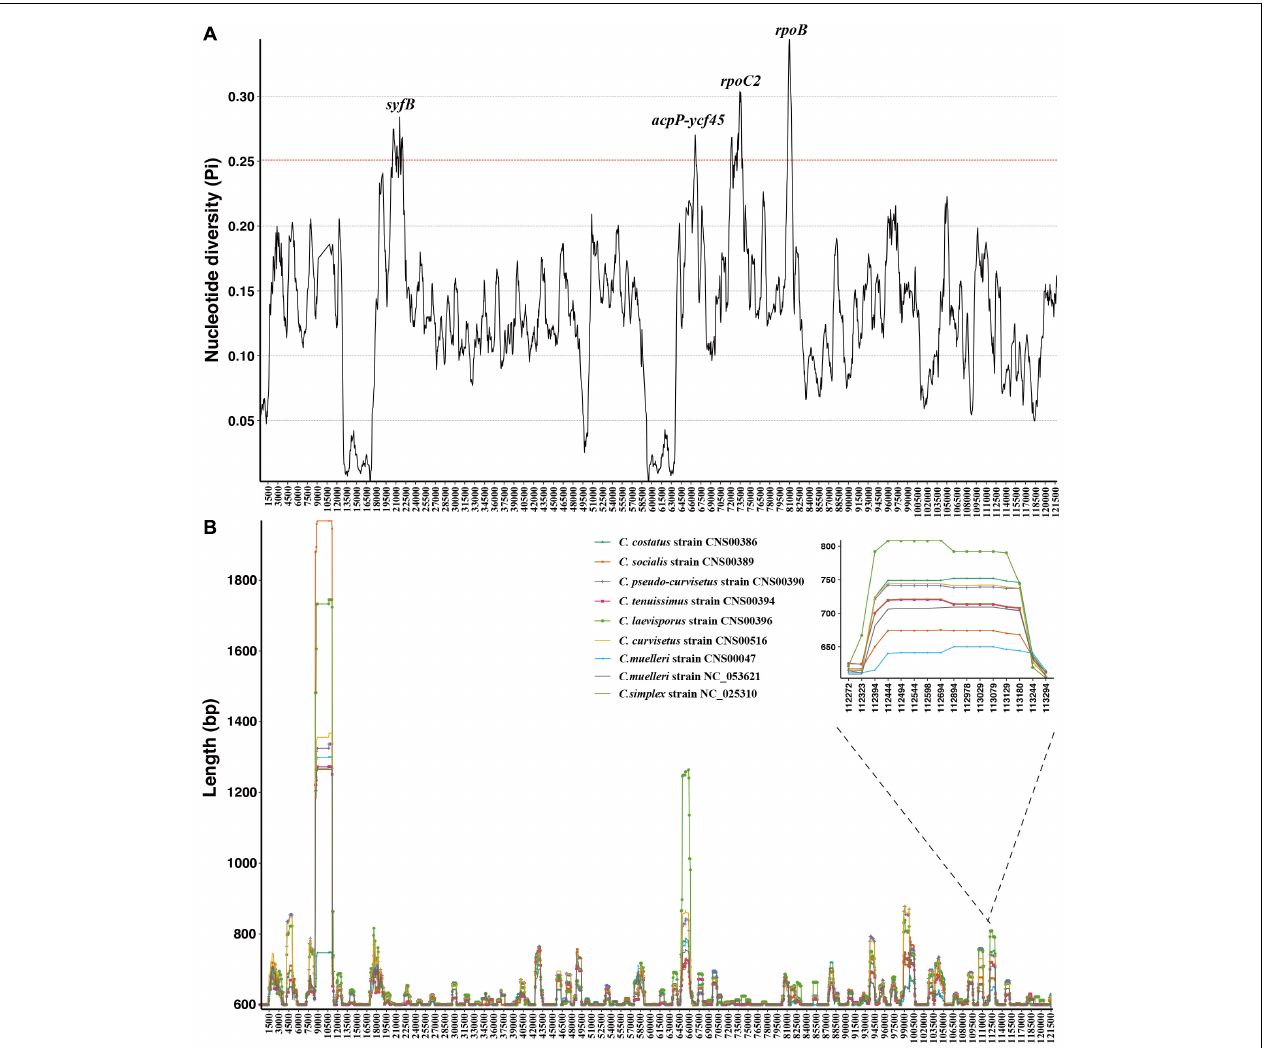
FIGURE 6 | Sliding window analysis of aligned whole cpDNAs of the Chaetoceros . Window length, 600 bp; step size, 50 bp. (A) Based on nucleotide diversity values and (B) the distribution of